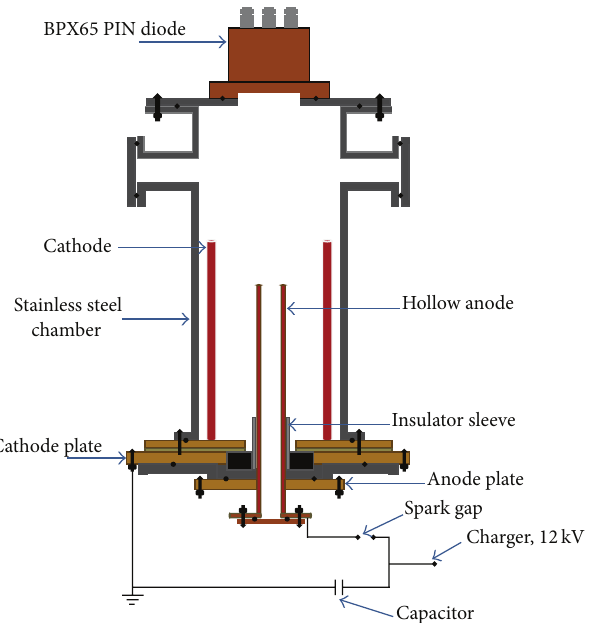
Figure 2: Schematic of Faraday cup.